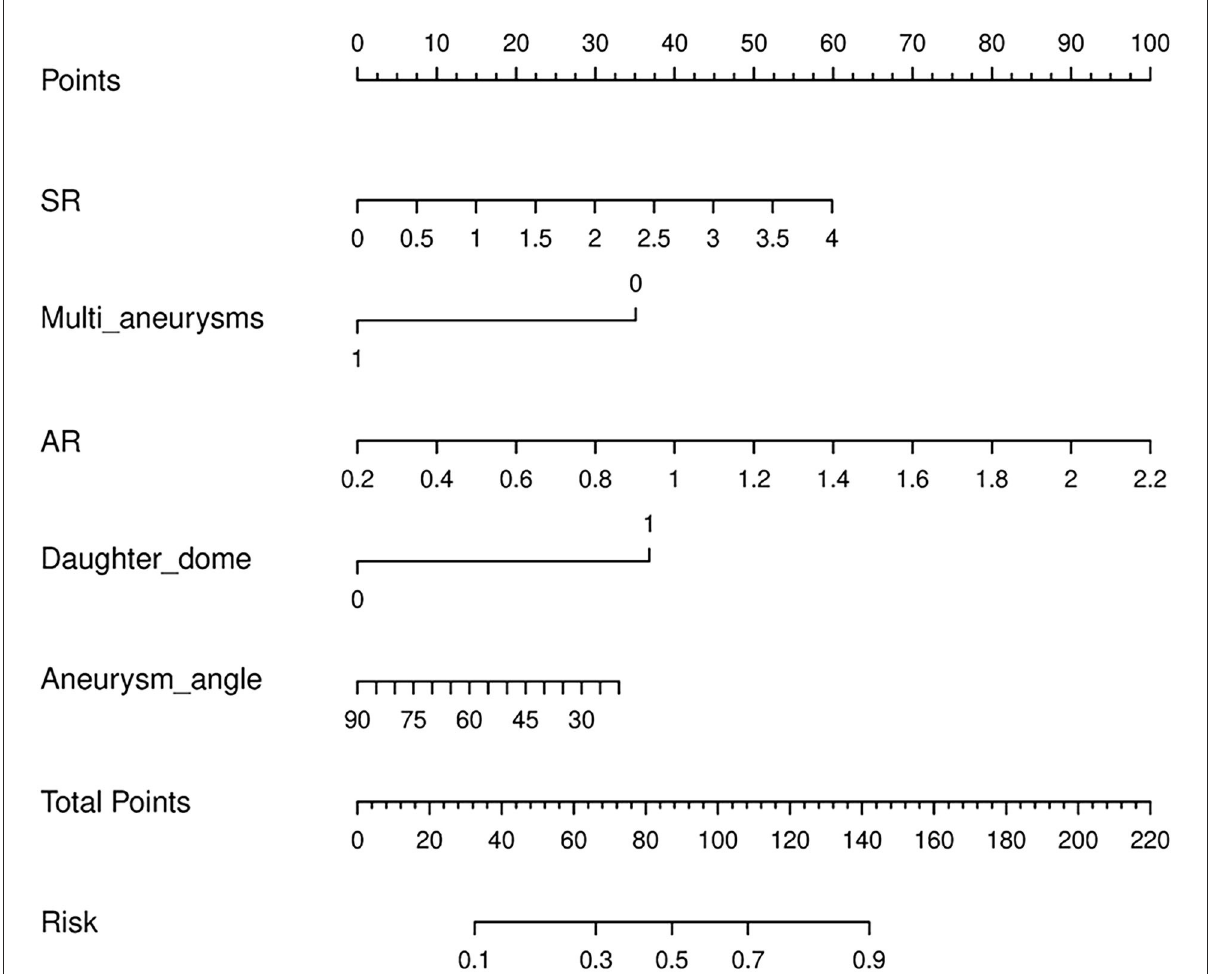
FIGURE4 A nomogram for predicting small middle cerebral artery aneurysm rupture. The nomogram incorporated five attributes: SR, multi aneurysms, daughter dome, AR, and aneurysm angle. To use the nomogram, read the scoring points from the “Point” reference line in line with the variable, add the points from all the variables, and find the predicted probability of rupture risk at the bottom “Risk” line. AR, aspect ratio; SR, size